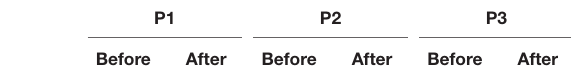
Frontiers in Pediatrics |